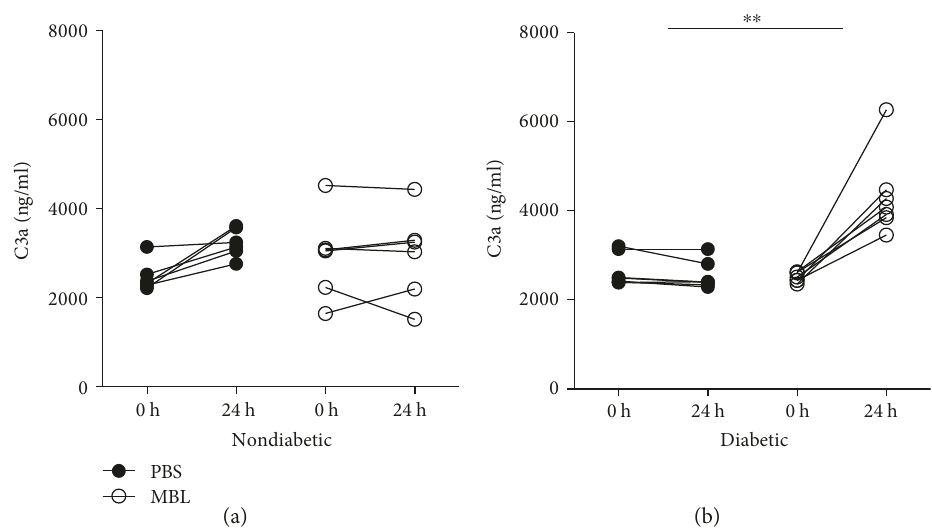
Figure 6: Circulating C3a as a measurement of complement activation. The di ff erence in change of C3a plasma levels from 0 h to 24h between the nondiabetic (a) and the diabetic (b) groups was tested by Student ’ s t -test on delta values and indicated in the fi gure when signi fi cant. ∗∗ p < 0 01 . Data is given in mean with standard deviations